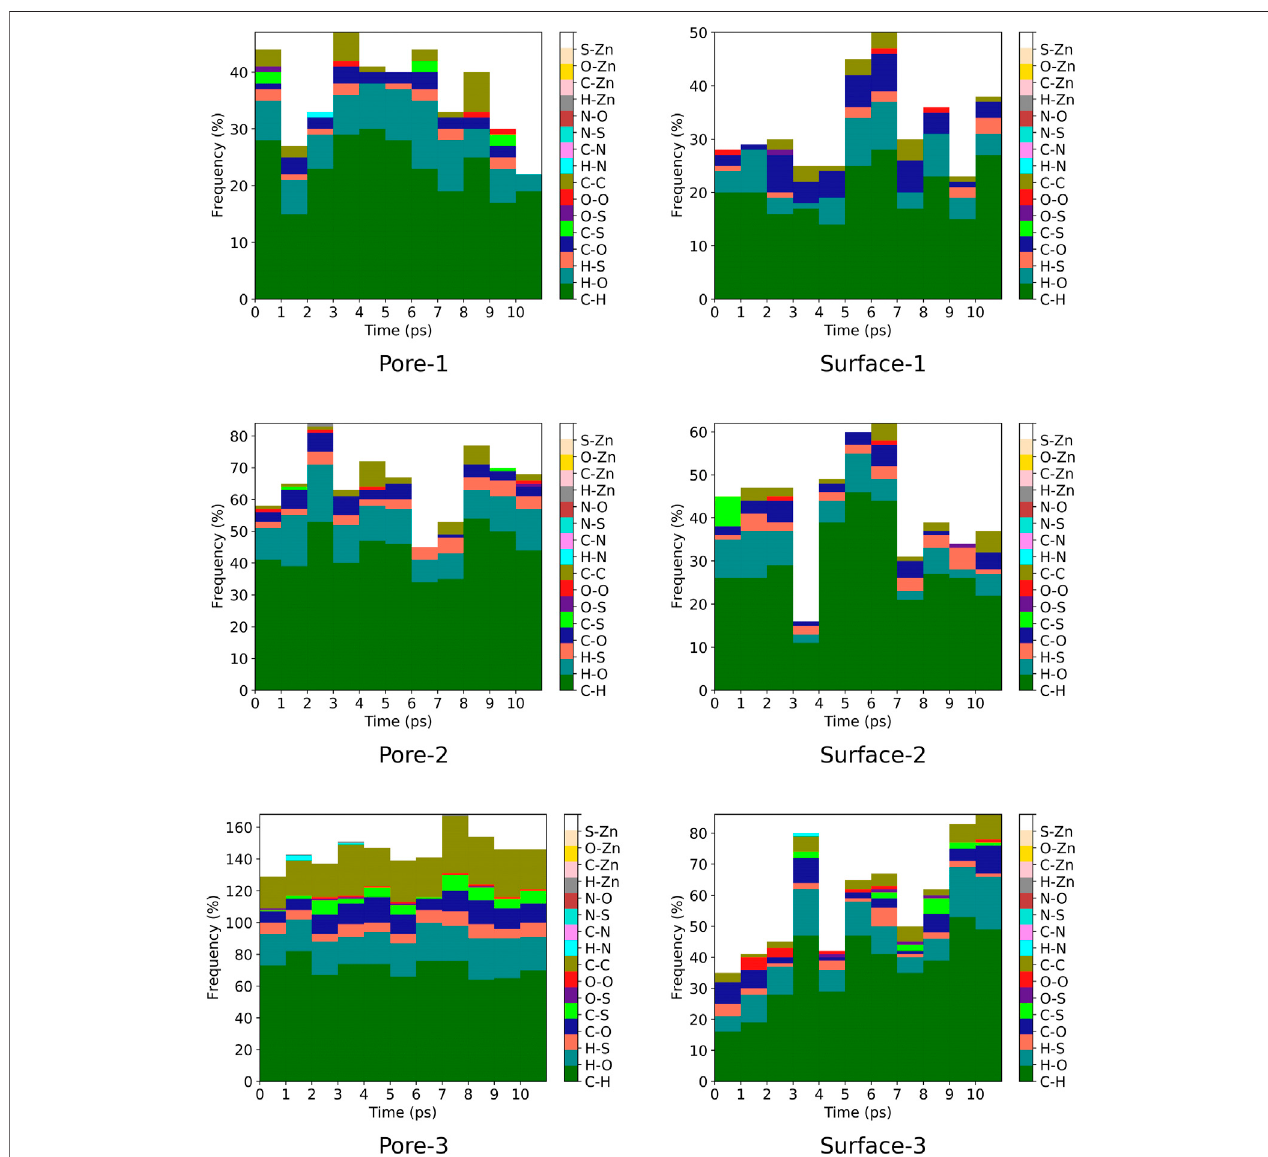
FIGURE7| FrequencyofZnPW I EDOTintermolecular distances(r < 3.5 Å)fornanochannelandsurfaceinteractions.Thecolourgradientcorrespondstospeci fi c interatomic interactions and each column correspond to a molecular dynamic trajectory snapshot. Interactions were computed at every 10 ps for systems representing nanochannel interactions and every 1 ps for systems representing surface interactions. The labels ” Pore ” and ” Surface ” correspond to nanochannel and surface interactions respectively and the numbers after the hyphen correspond to the number of monomer(s) present.